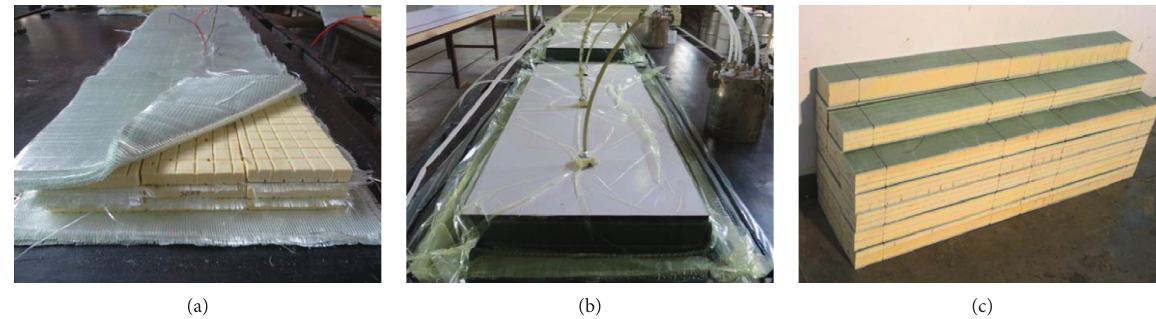
Figure 2: Fabrication process of the GHP specimens. (a) Assembly of the PU foam and GFRP. (b) VIP process. (c) Test